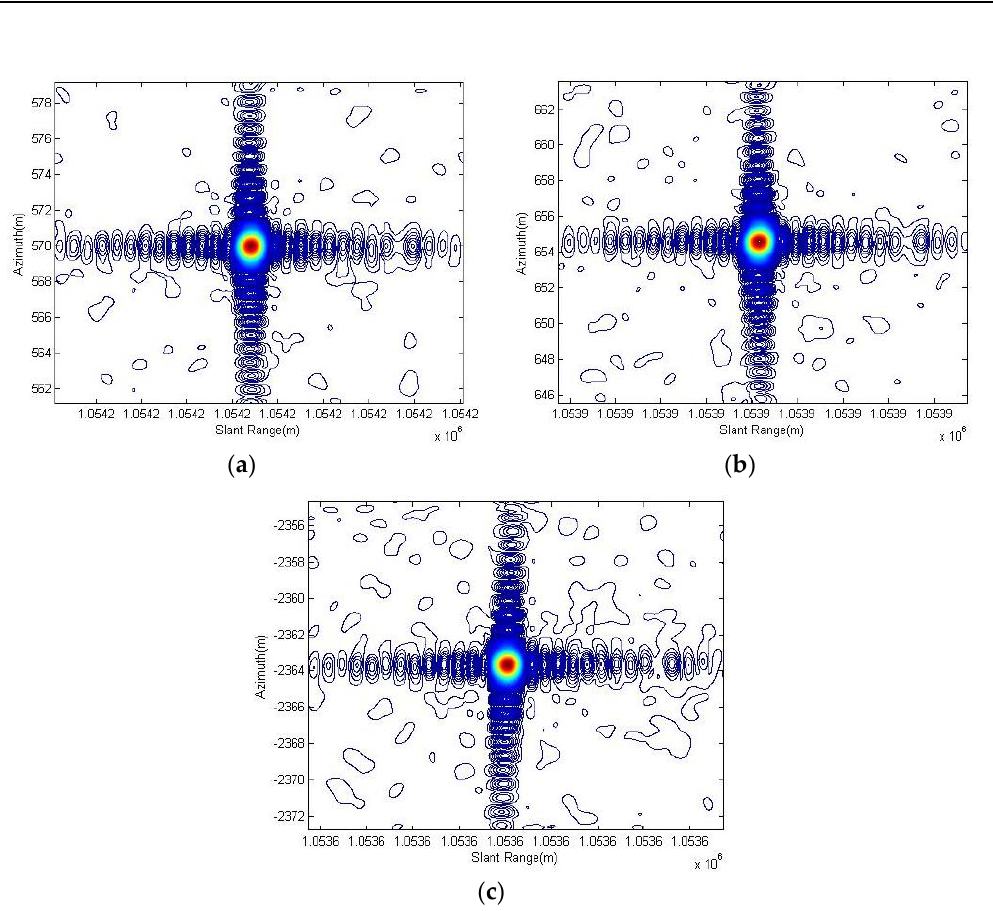
Figure 7. The contour images of corner reflector No. 1, corner reflector No. 2 and corner reflector No. 3 are shown in ( a – c ) respectively. These were given before the spotlight processor applied the enhancements.